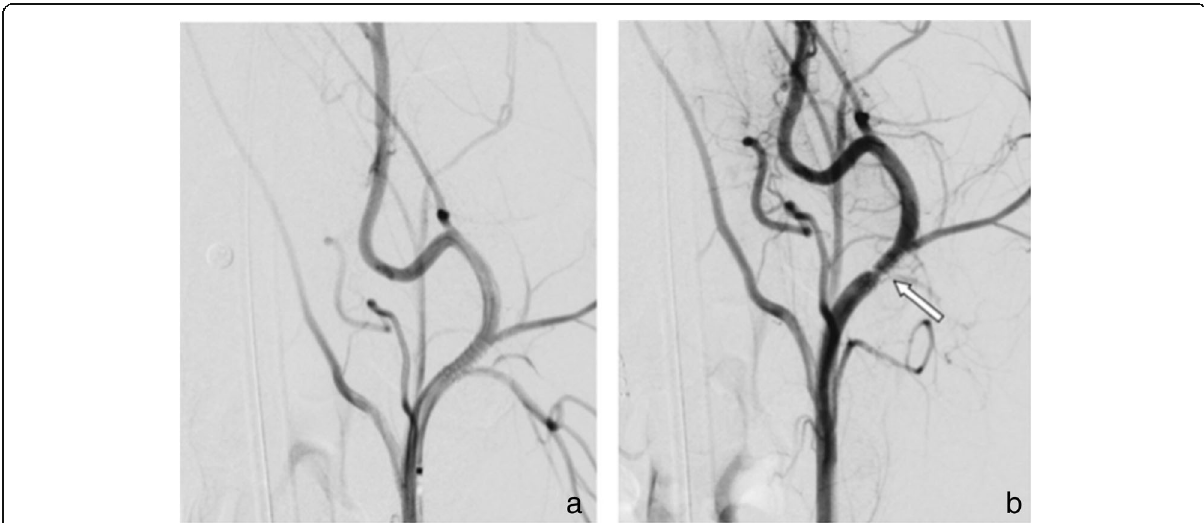
Fig. 1 Subtracted angiographic series of the left external carotid artery of subject number 2 (treated with ASA only), implanted with an uncoated p64 device. a The FDS immediately after its implantation. b The formation of multiple thrombus in the acute phase (white arrow), 30min after implantation